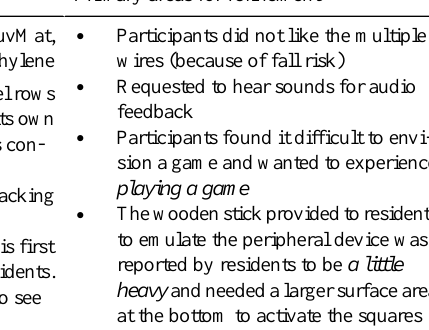
Primary areas for refinementDescription of